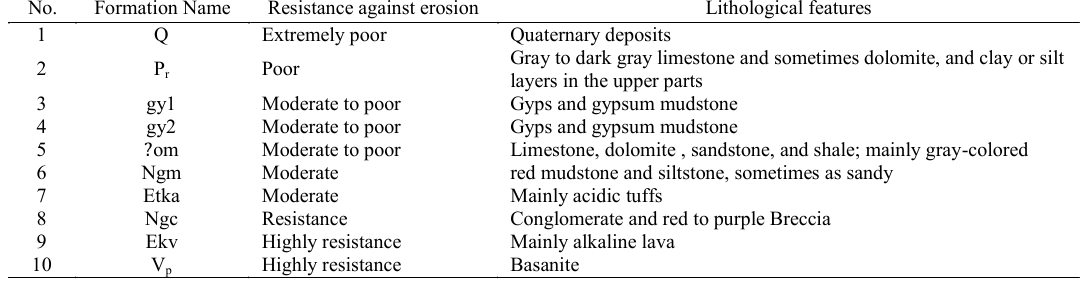
Lithological featuresResistance against erosionFormation NameNo.